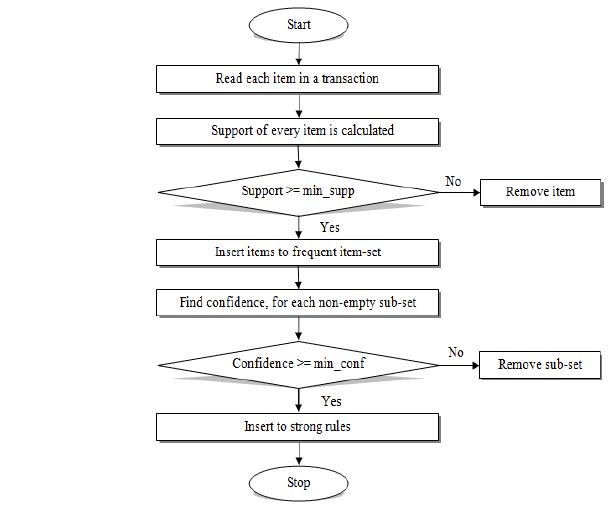
Fig. 1. Flowchart of apriori algorithm